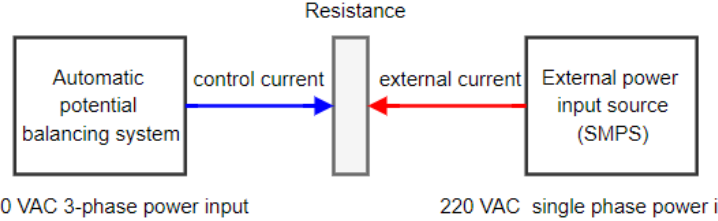
Figure 7. Test method for electric pitting prevention device.